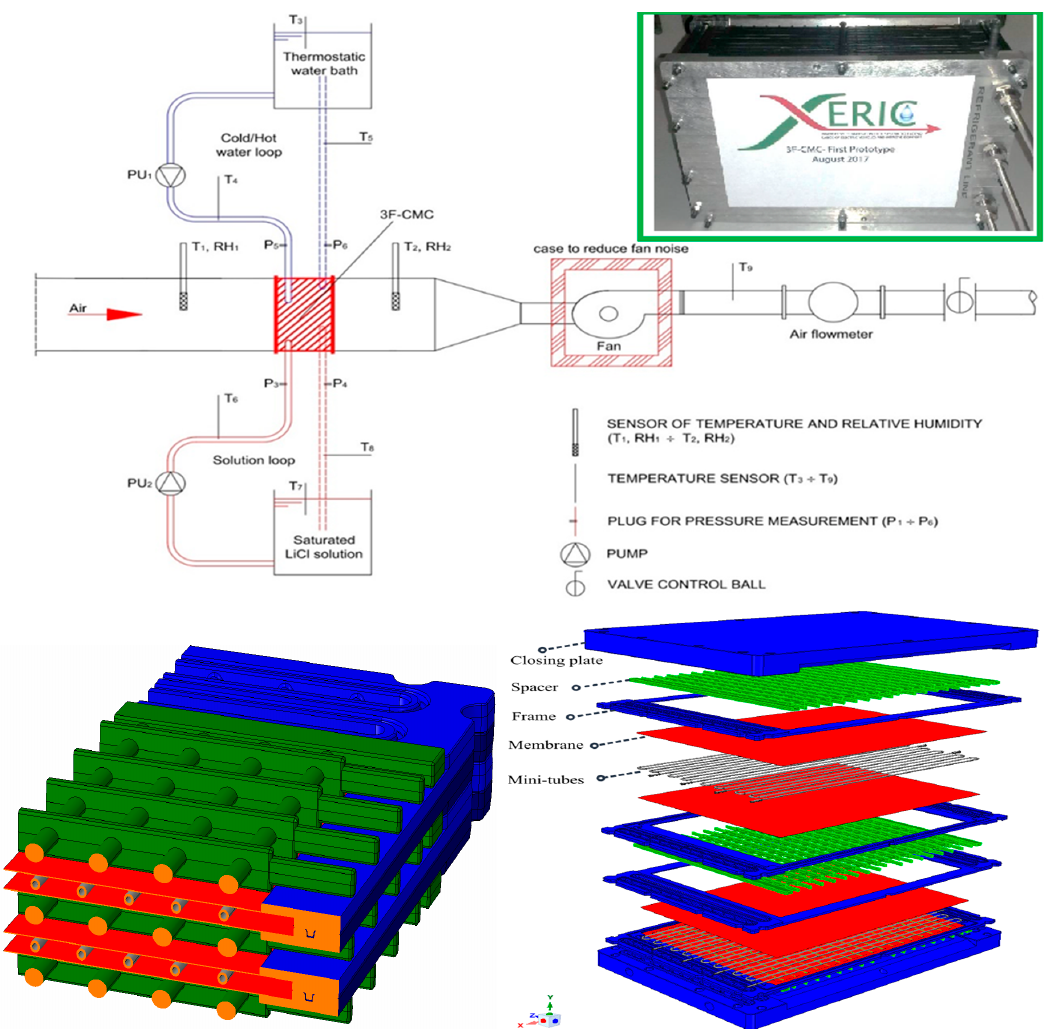
Figure 1. ( Top ) Scheme of the experimental setup for absorption test showing the 3F-CMC prototype in the green frame. ( Bottom ) A magnified section ( left ) and a break-down view ( right ) of two modules of the 3F-CMC Computer Aided Design (CAD), illustrating the air and solution channels, spacer (in green), mini-tubes (in gray), membranes (in red), closing plates, and frames (in blue).